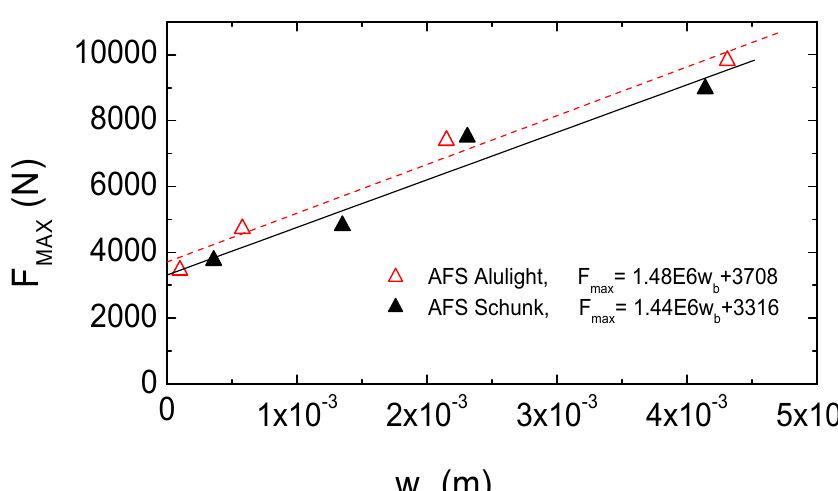
Figure 15. Peak load vs. sandwich